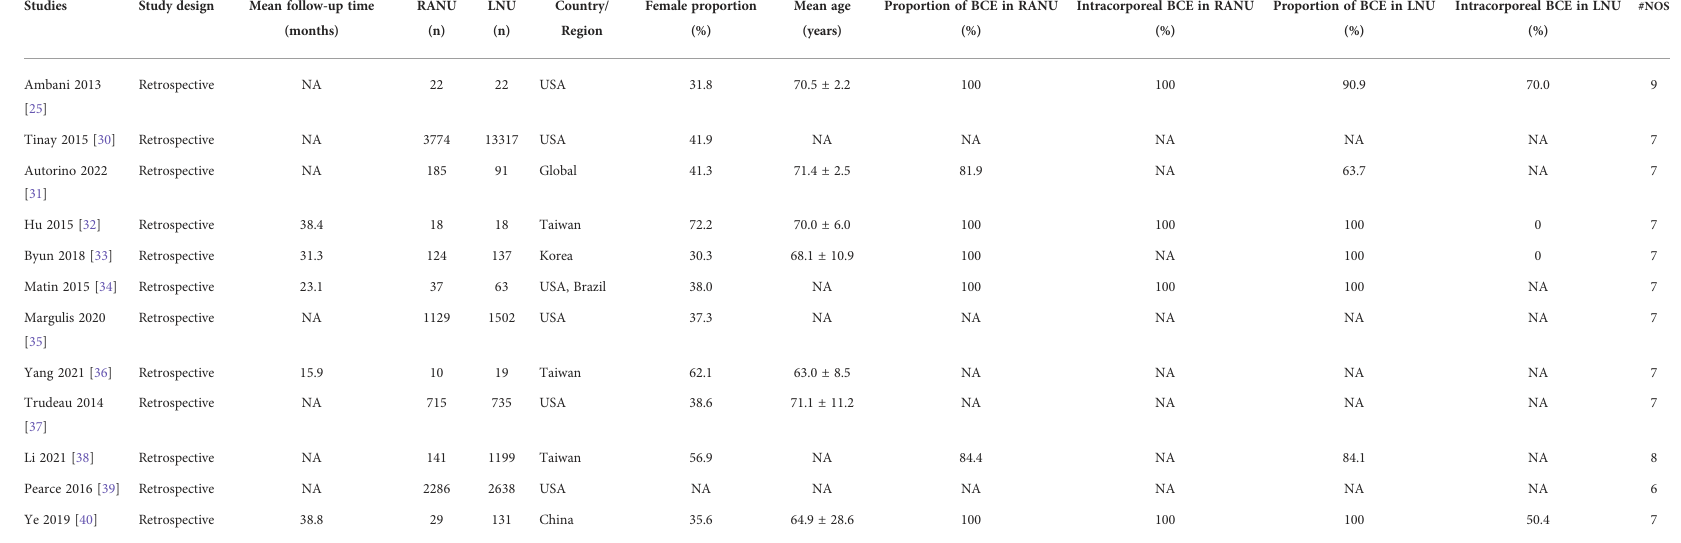
TABLE 1 Basic characteristics of included studies.